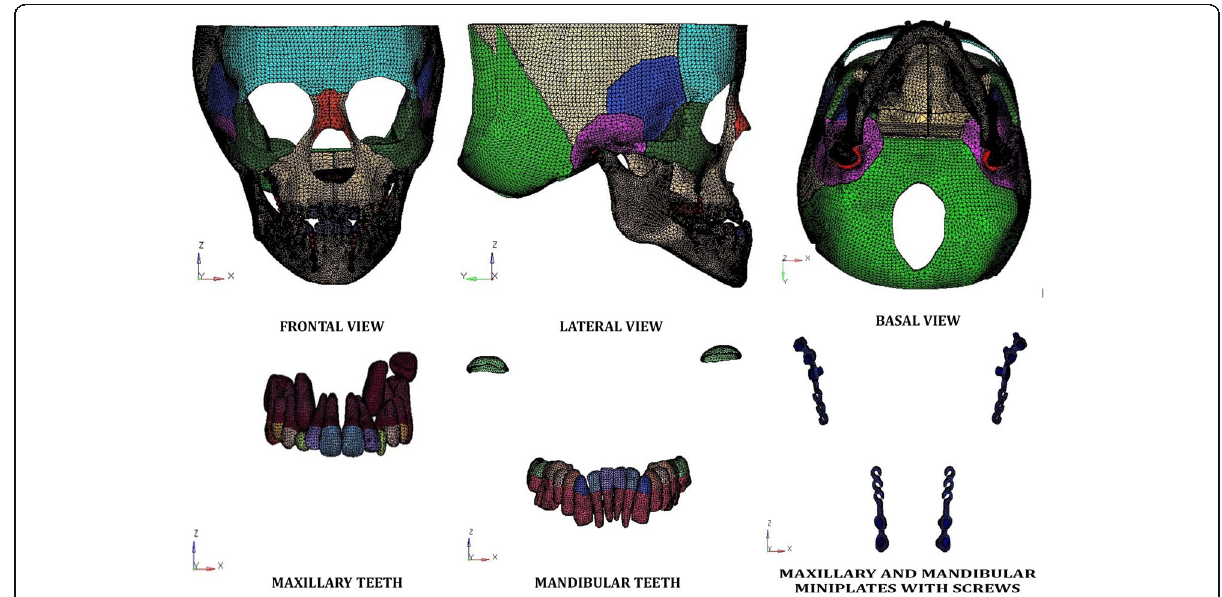
Fig. 2 Three-dimensional mesh FE model with the maxillary, mandibular teeth and miniplates and